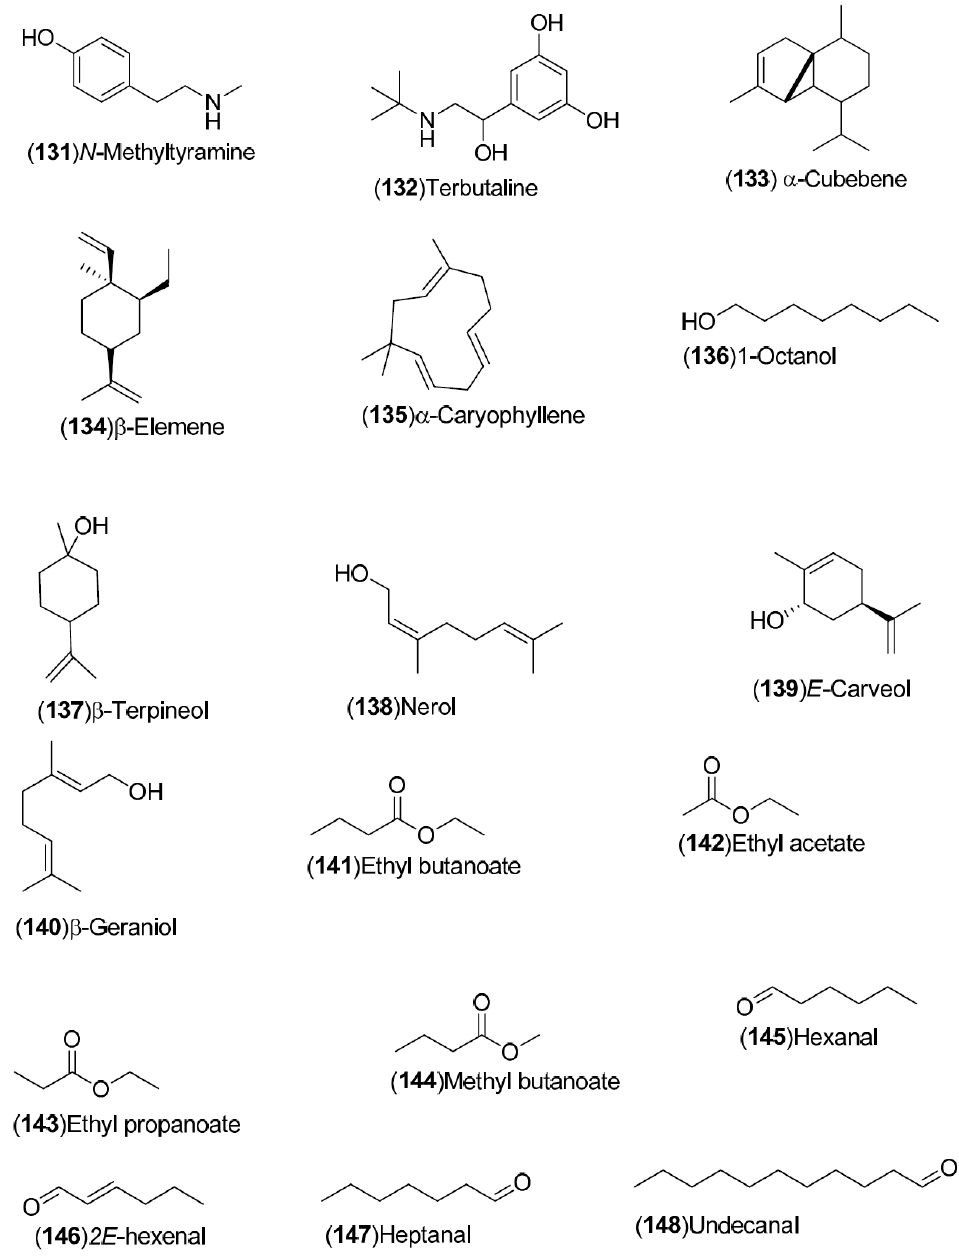
Figure 9. Chemical structures of volatile compounds.